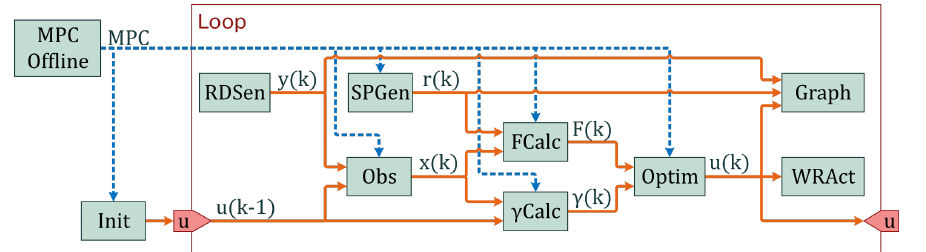
Figure 5. Process flow diagram of the MPC